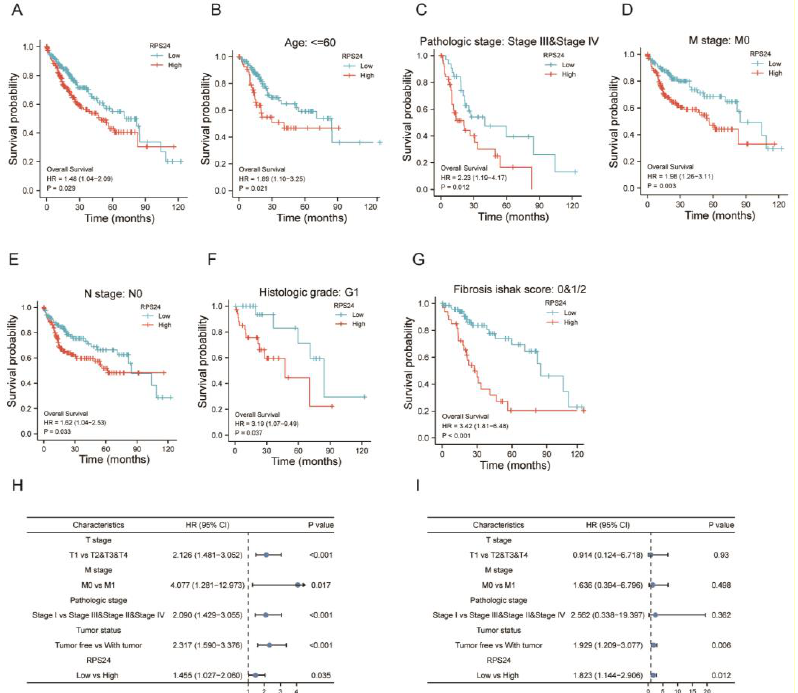
Figure 3. High expression of RPS24 and poor prognosis in HCC. ( A ) The OS survival curve between high and low expressions of RPS24 was drawn using the TCGA-LIHC dataset. ( B – G ) The OS survival curves of HCC between high and low expressions of RPS24 in subgroups according to age of ≤ 60 years ( B ), pathological stages III and IV ( C ), M0 ( D ), N0 ( E ), G1 grade ( F ), and Fibrosis ishak score: 0&1/2 ( G ). ( H , I ) Forest plot showing univariate ( H ) and multivariate analyses ( I ) of RPS24 in the TCGA-LIHC